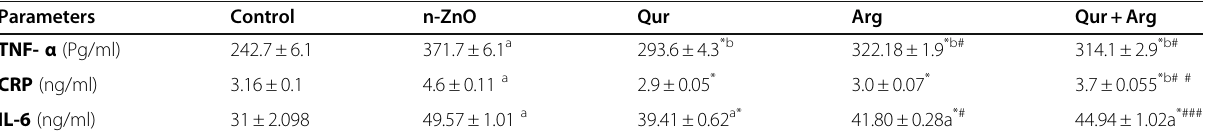
Table 2 Effect of Qur and/or Arg treatment on serum inflammatory marker levels in intoxicated rats with a high dose of n-ZnO